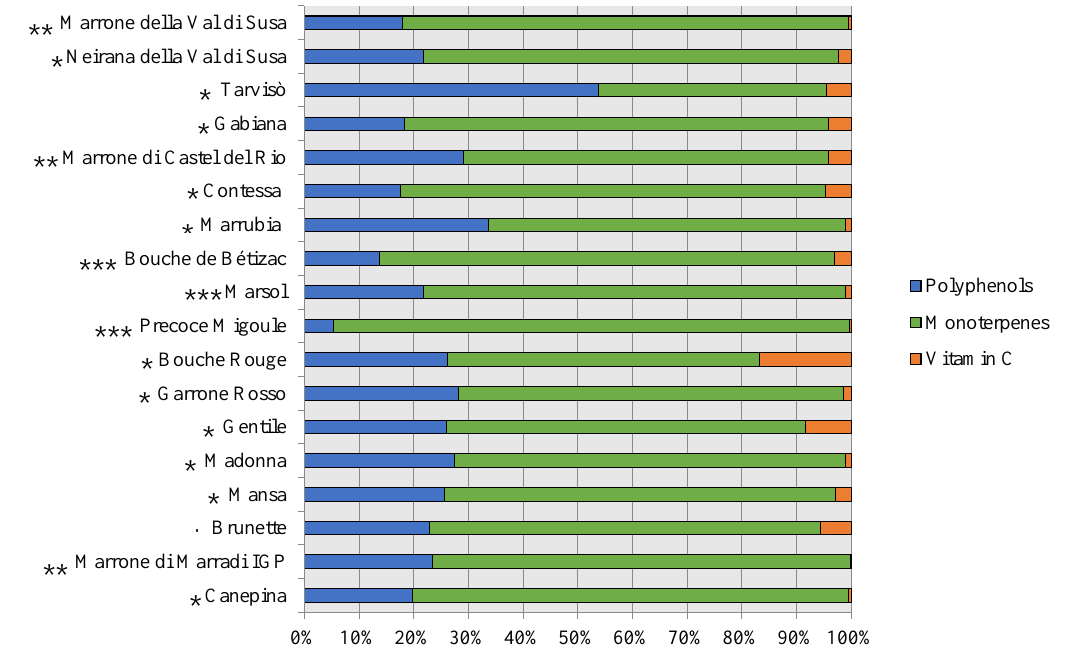
Figure 6. Phytocomplex representation of the analysed chestnut cultivars. The colours identify the different classes: blue corresponds to polyphenols, green to monoterpenes, and orange to vitamin C. * Sweet chestnut (SC). ** Marrone-type chestnut (MT). *** Euro-Japanese hybrid (EH). Monoterpenes, recognised for their anti-tumour and anti-inflammatory properties [61], represented the main component of the phytocomplex, reaching the 88% of EH cultivars, followed by polyphenols, characterised by antioxidant, anti-bacterial, and anti-tumour properties [62], and is between 10 and 25% for EH and SC, respectively, and has vitamin C in low quantities (2%). However, the cultivar ‘Tarvisò’ showed a higher proportion of polyphenols than monoterpenes. The highest levels of polyphenols and monoterpenes were detected in ‘Canepina’ (0.19 g·kg −1 DW and 0.76 g·kg −1 DW, respectively), a cultivar from central Italy, while the highest values of vitamin C were observed in the French cultivar ‘Bouche Rouge’ (0.19 g·kg −1 DW) as shown in Table 4.